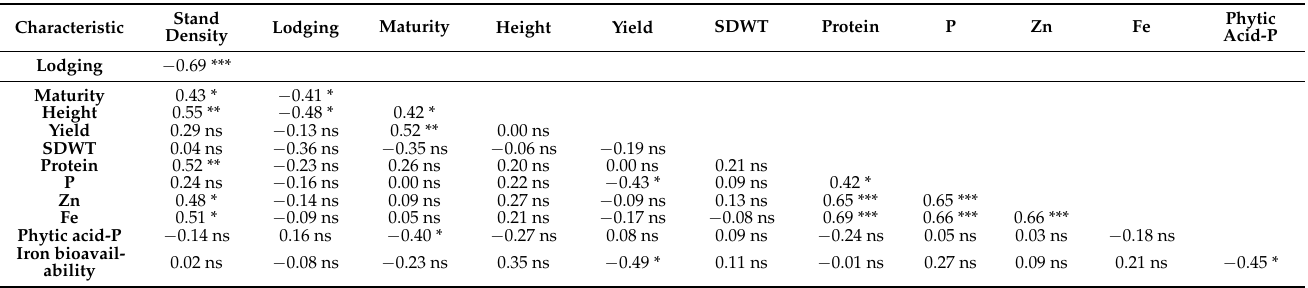
Table 2. Pearson correlation analysis of performance traits of 24 pea lines evaluated from 2017 to 2020 at Kamsack, Meath Park, Rosthern, and Saskatoon locations in Saskatchewan.